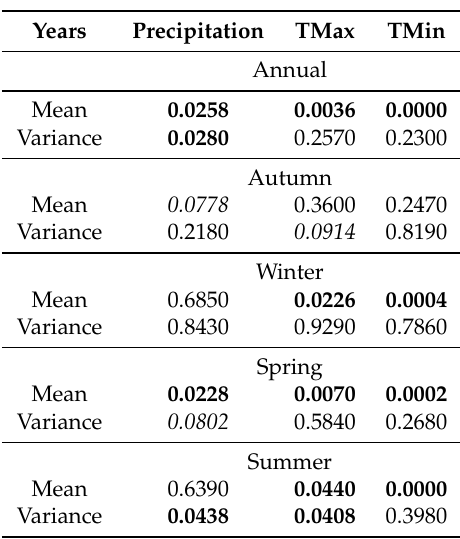
Table 2. p -values for the permutation test on the difference between the mean and variance of precipitation, TMax or TMin between 1958–1988 and 1989–2019, annually and across all four seasons. Tests conducted used 5000 resamples. Text in bold face highlights statistical significance at the 95% confidence level; text in italics highlights statistical significance at the 90% confidence